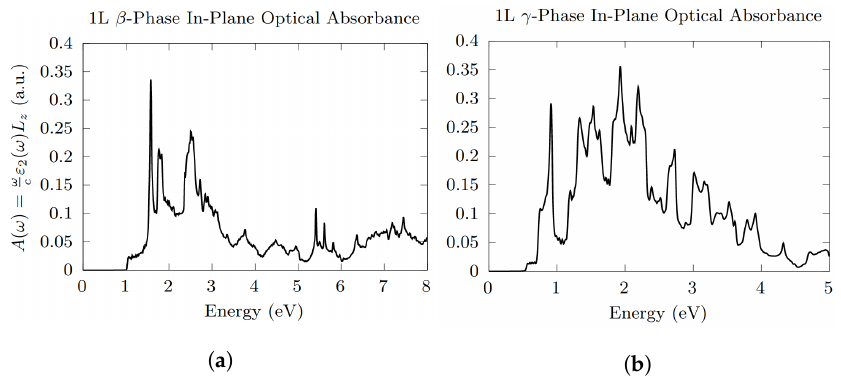
Figure 7. In-plane optical absorbance of ( a ) ML β - and ( b ) γ -Te, with the inclusion of SOC. Absorption energy threshold estimated values of 1.02 eV and 0.54 eV,